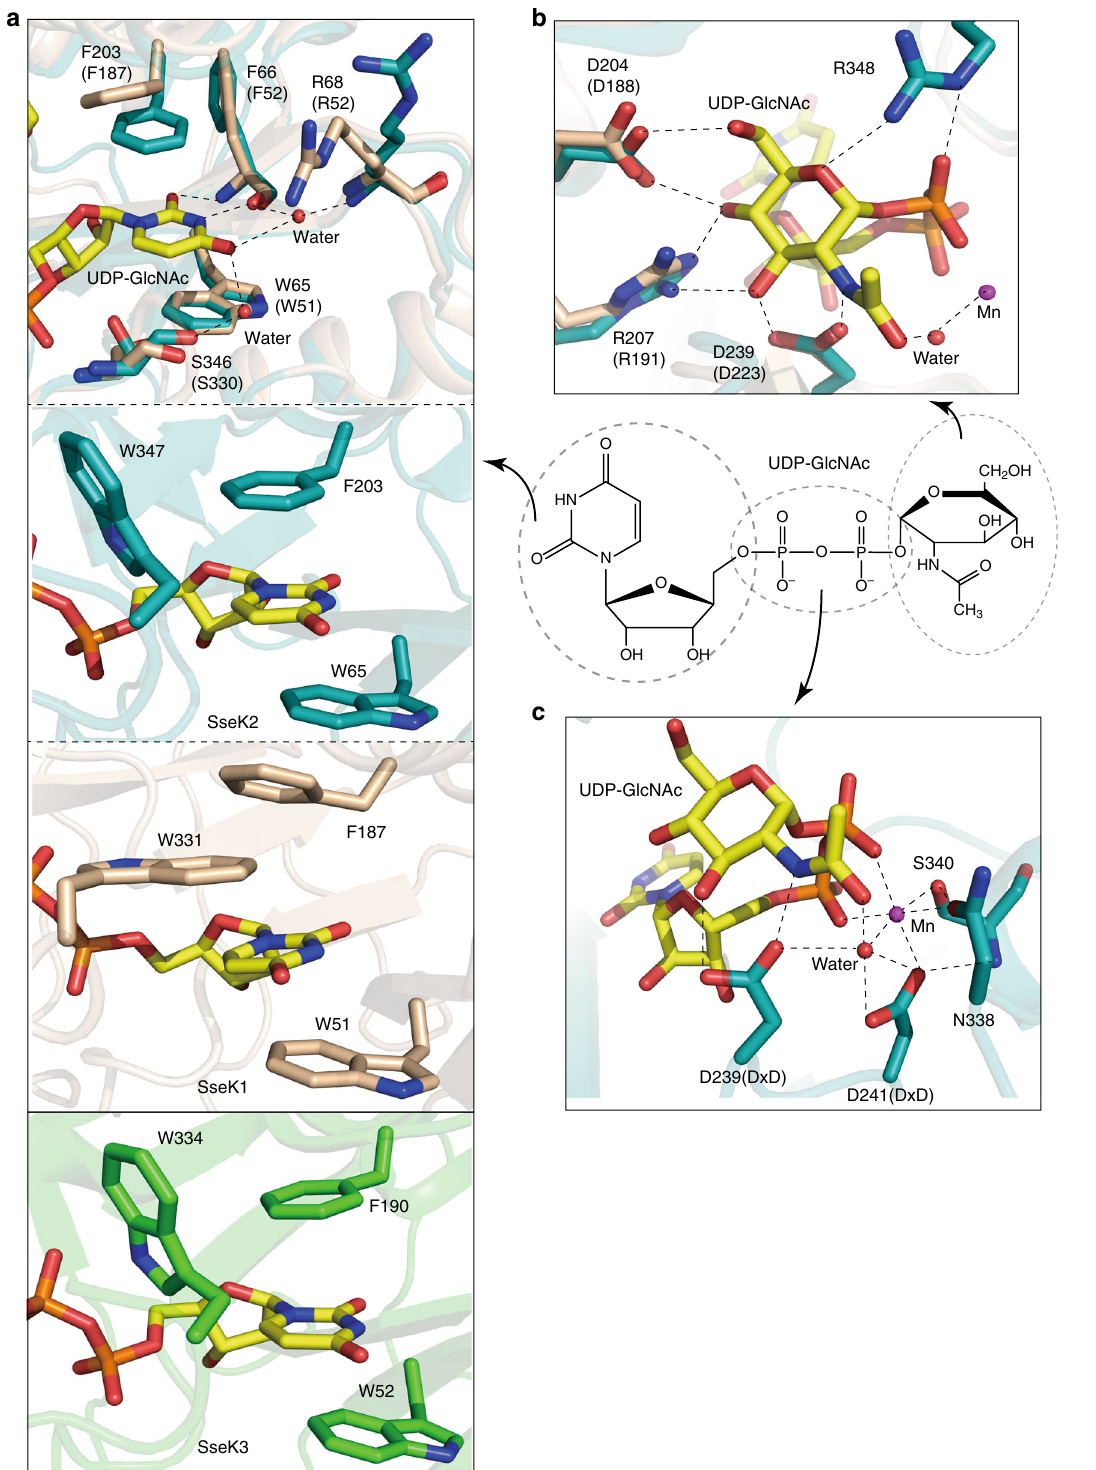
Fig. 3 UDP-GlcNAc binding mode in SseK2. a Uracil moiety of UDP-GlcNAc interacts with SseK2 through hydrogen bonds and π - π stacking (top panel), but SseK1 uses a slightly different mechanism (second and third panel). Uracil binding mode of SseK3 is similar to SseK2 instead of SseK1 (bottom panel). b GlcNAc moiety of UDP-GlcNAc interacts with Asp204, Arg207, Asp239, and Arg348 by hydrogen bonds. The carbonyl group of the acetyl of GlcNAc interacts with a water molecule to stabilize the divalent metal ion. c Manganese ion coordinates six oxygens from pyrophosphate, Ser340, Asn338, Asp241, and water. The DxD motif stabilizes both UDP-GlcNAc and manganese ion. *Amino acid numbering in brackets refers to conserved sequence of SseK1. Black dashed lines represent hydrogen